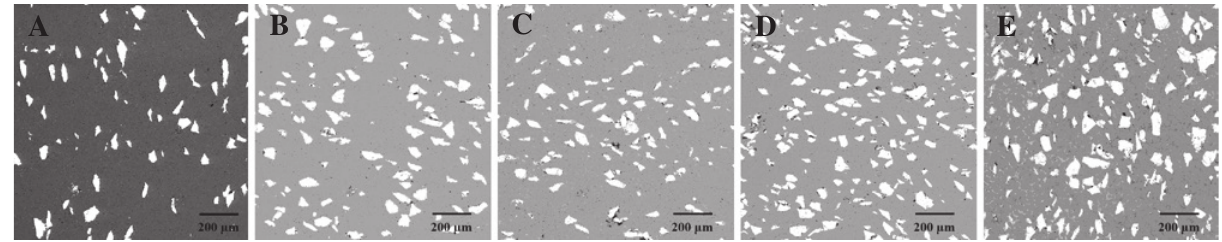
Figure 6: SEM micrographs of the internal microstructure of the composite Cu-WC with different volume fractions of reinforcing particles: (A) 5%, (B) 10%, (C) 15%, (D) 20%, and (E) 30%.